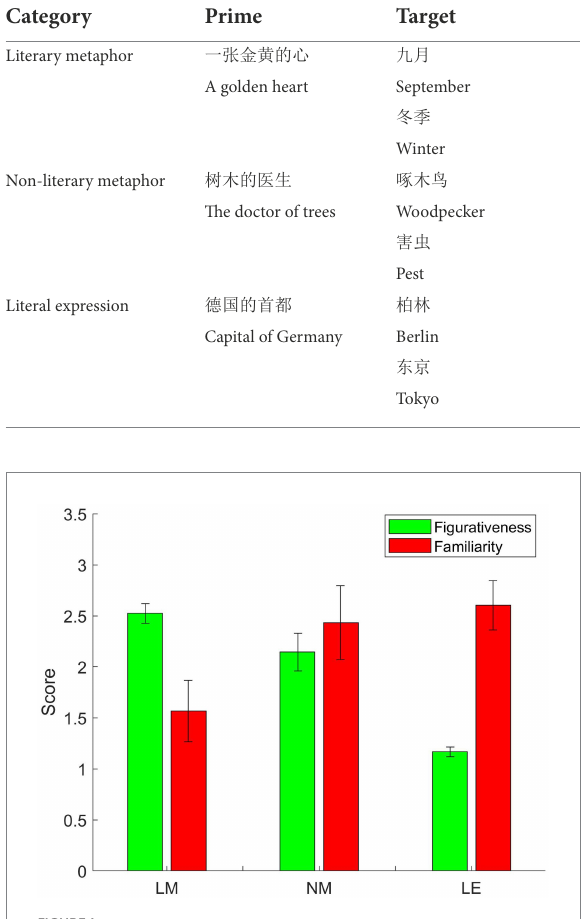
TABLE 1 Sample stimuli in the ERP study.